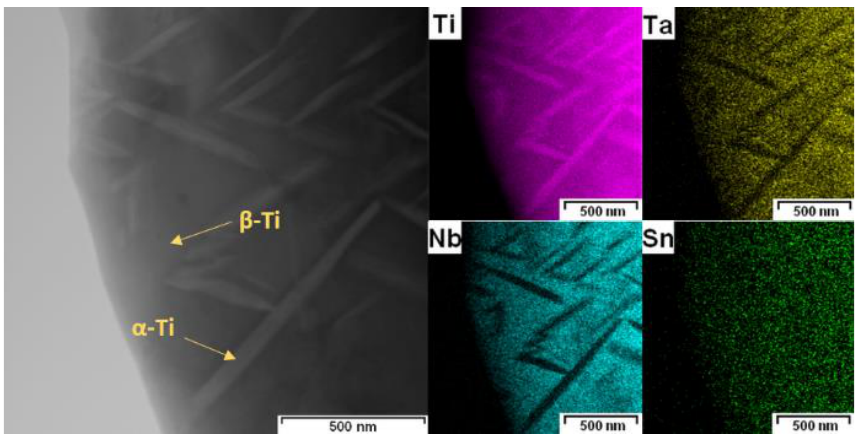
Figure 9. Elemental mapping images of SPS_HT sample (TEM – EDS).